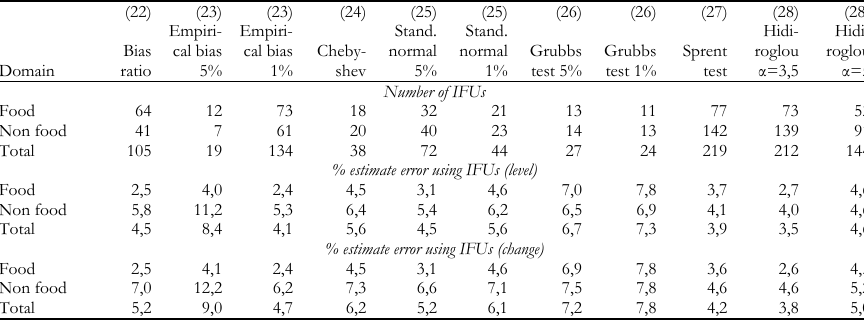
Main results using function Ф 2 and option a), formula (2), with options (13) and (14) for a conjoint IFUs identification (level and change)